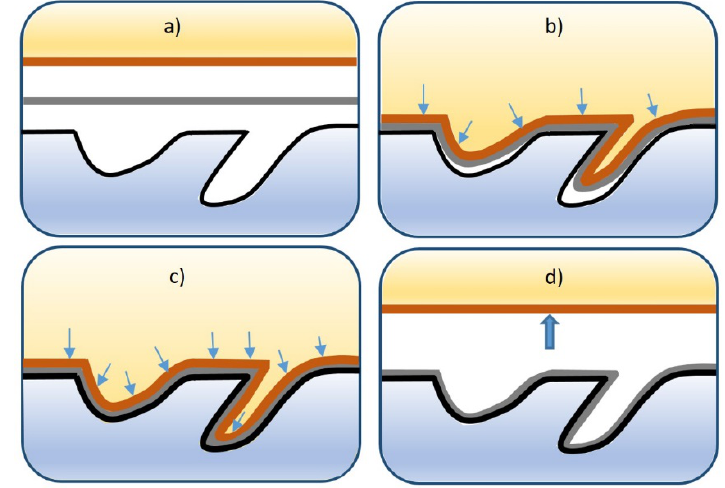
Figure 3. Schematic steps of Flexform process: ( a ) Initial pressure application; ( b ) Sheet partially hydroformed; ( c ) Sheet completely hydroformed; ( d ) Elevation of